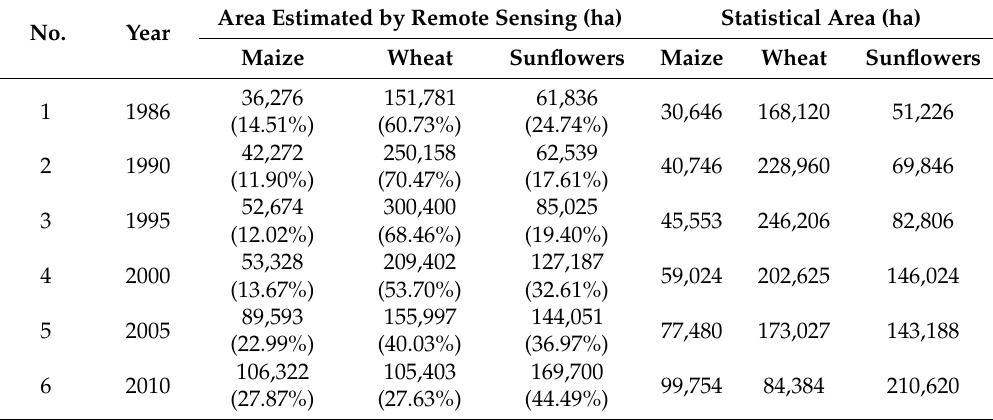
Figure 10. Estimated area of different land use ( a ) and comparison of the statistical data and the cultivated land area estimated by remote sensing ( b ). Table 5. Comparison of the area estimated by remote sensing and the statistical data for maize, wheat, and sunflowers in di ff erent